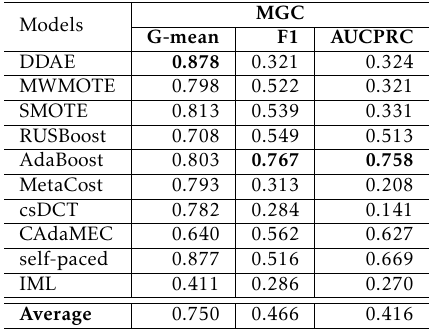
Table 13. Overall Results for WDBC Dataset Models